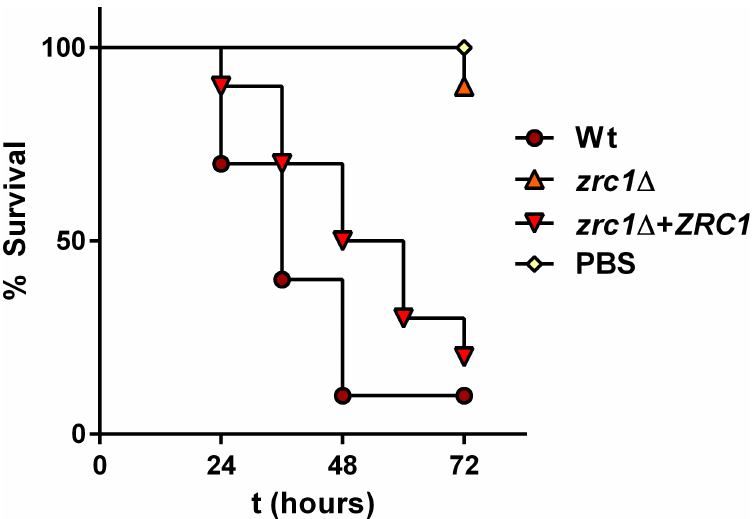
Fig 13. Zrc1 is required for virulence in a Galleria infection model. Galleria larvae (10 per group) were infected with 10 5 C . albicans cells and monitored every 12 h. Note that whilst wild type result in high mortality, only one zrc1 Δ - infected larvae died. Experiment performed twice—here, and in S8 Fig. zrc1 Δ is significantly attenuated compared to wild type (P = 0.0001) and zrc1 Δ + ZRC1 (P = 0.0009), but not compared to PBS control (P = 0.3173); Log-rank (Mantel-Cox) test.